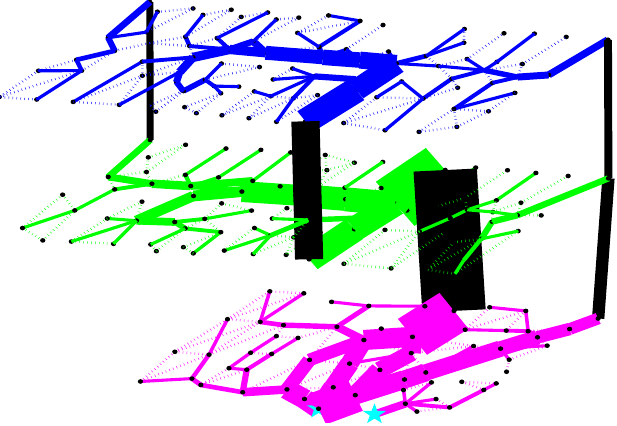
Figure 14. CPN energy efficiency metric